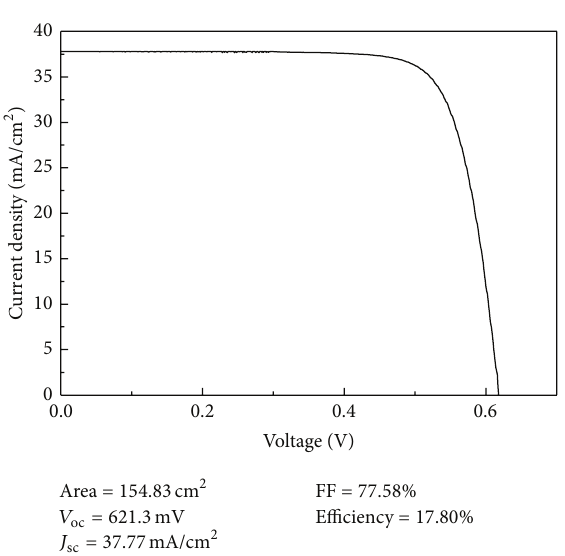
Figure 6: J - V characteristics of the solar cell with SiO 2 (105nm)/SiN :H (80 nm) DARC (AM1.5 G, 100 mW/cm 2 , 25 ∘ C). x